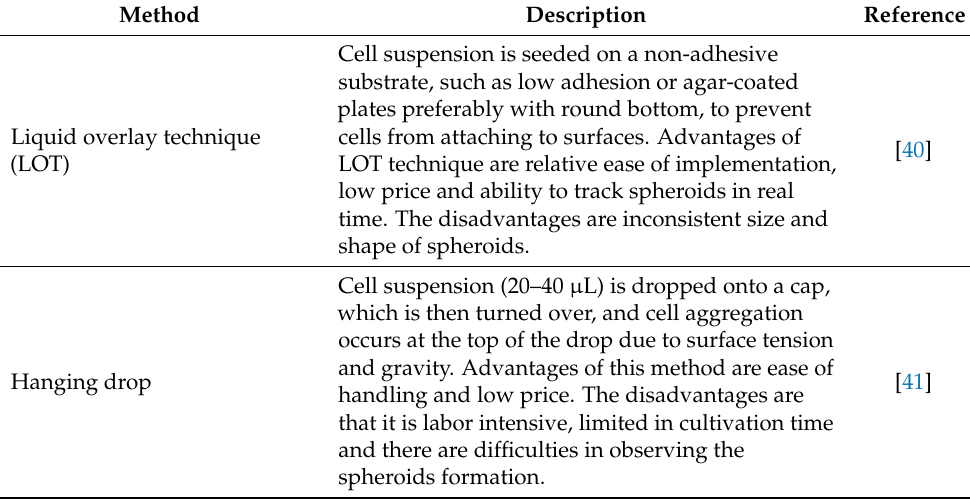
Table 1. Methods of spheroids